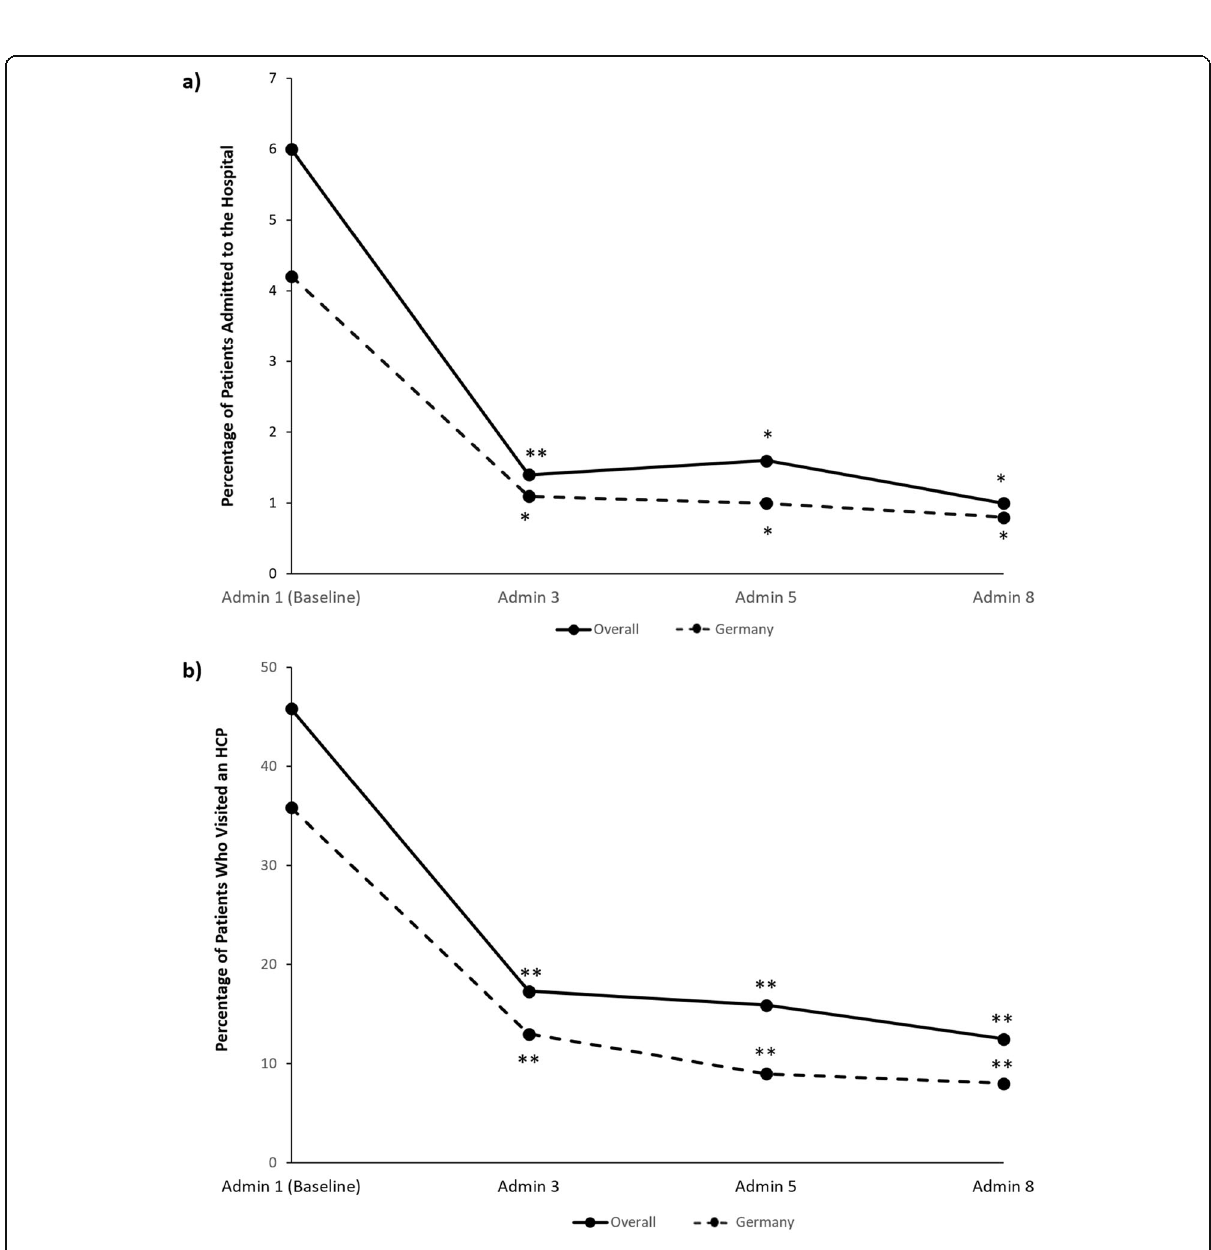
Fig. 2 a Percentage of patients who reported a headache-related hospitalization in the 3 months prior to baseline or since the last onabotulinumtoxinA administration for follow-up visits; b Percentage of patients who visited any HCP in the 3 months prior to baseline or since the last onabotulinumtoxinA administration for follow-up visits. The number of patients in administration (Admin) visits for the overall and German populations are as follows: Admin 1, n = 633 overall, n = 377 Germany; Admin 3, n = 485 overall, n = 270 Germany; Admin 5, n = 371 overall, n = 210 Germany; Admin 8, n = 200 overall, n = 123 Germany. * P < 0.02, ** P < 0.0001 McNemar test for difference versus baseline (level of significance, 5%). Abbreviations: Admin, administration; HCP, healthcare